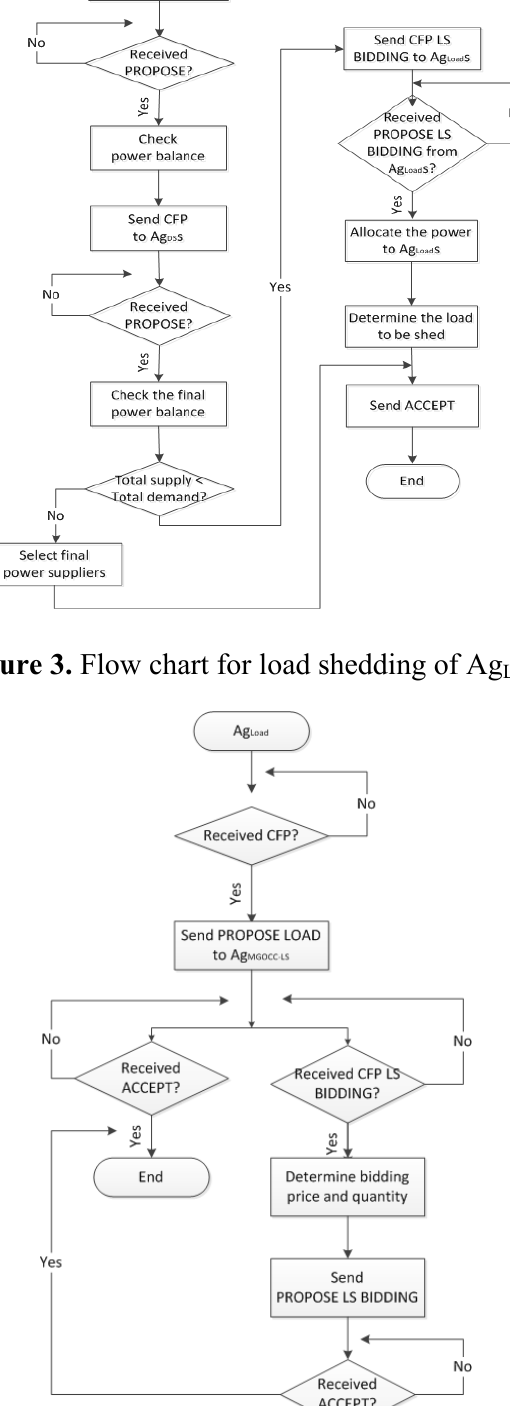
Figure 2. Flow chart for load shedding of Ag